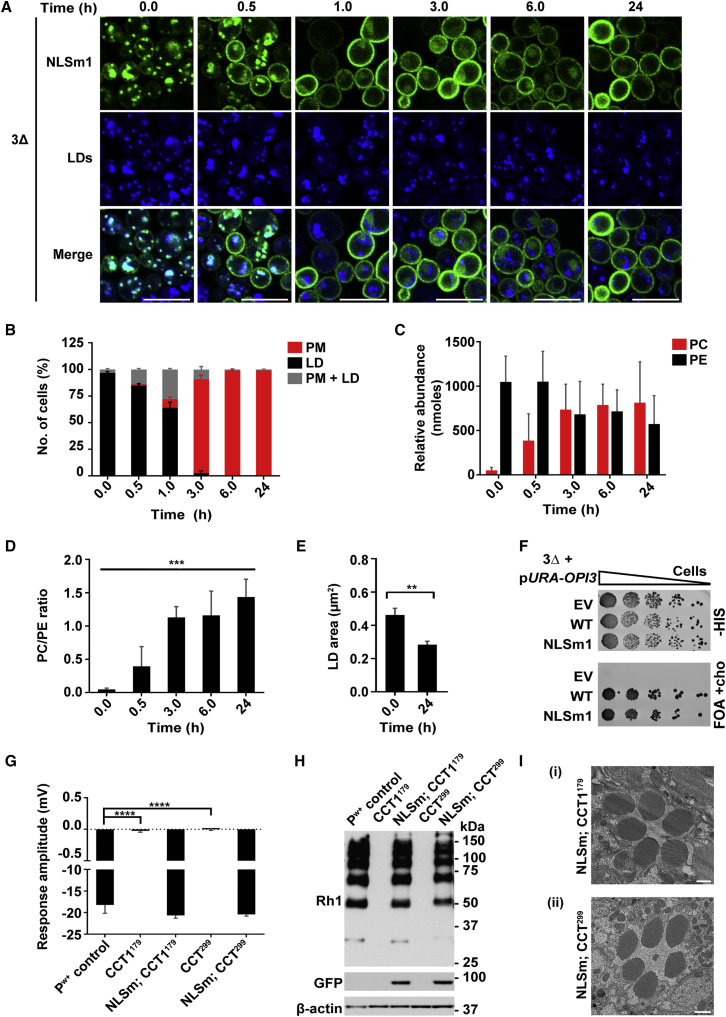
CCT NLS Mutants Can Compensate for the Loss of WT CCT in Yeast and in Drosophila PRs(A–F) 3Δ yeast cells expressing Pct1-NLSm1-GFP were grown for 24 hr followed by addition of 1 mM choline. Cells were collected before (0.0 hr) and after choline supplementation at the indicated time points for imaging or lipidomics analysis.(A) Representative confocal microscopy images of Pct1-NLSm1 localization. LDs were stained as described in the STAR Methods. Merged (Merge) fluorescent channels show co-localization. Scale bars, 10 μm.(B) Quantification of the Pct1-NLSm1-GFP localization shown in (A); PM, plasma membrane; LD, Lipid droplet. Data are means ± SD based on random fields from three independent experiments; ∼300 cells were counted at each time point per experiment.(C) PC and PE levels at the indicated time points shown in nmol (per 50 mg yeast) are relative to internal standards. Data represent the means ± SD based on measurement from three independent experiments.(D) PC/PE ratio at the indicated time points from data in (C). Data are means ± SD. One-way ANOVA, ∗∗∗p < 0.001.(E) Measurement of LD area from cells imaged in (A) as described in the STAR Methods. Data are means ± SD from three independent experiments; ∼600 LDs were counted per condition. Two-tailed Student's t test, ∗∗p < 0.01.(F) 3Δ cells carrying Ycplac33-URA3-OPI3 were transformed with CEN/HIS3 plasmids expressing either WT Pct1, NLSm1, or the corresponding empty plasmid (EV). Cells were grown to exponential phase and serial dilution of liquid cultures were spotted onto plates lacking histidine (-HIS) or plates supplemented with 5-FOA.(G–I) The “blind” phenotype of the CCT1179 and CCT299 homozygous eyes was rescued by transgenic retinal expression of a CCT1-NLSm-GFP mutant, CCT1-NLSm; CCT1179 and CCT1-NLSm; CCT299.(G) Response to light activation was assessed by ERG scans and the mean response generated at the maximal intensity was plotted for four to six flies of each genotype. Flies with CCT1 null eyes are completely blind even at the maximum intensity, while the CCT1-NLSm-GFP expression restores the response to WT levels. Data are reported as means ± SD. One-way ANOVA with Bonferroni multiple comparison, ∗∗∗∗p < 0.0001. (H) The CCT1-NLSm-GFP mutant restores the rhodopsin level in flies with CCT1 null eyes (CCT1179 or CCT299) back to the control levels. (I) Transmission electron micrographs of retinal tissue sections from flies with CCT1 null eyes rescued by transgenic expression of CCT1-NLSm-GFP mutant, CCT1-NLSm; CCT1179 (i) and CCT1-NLSm; CCT299 (ii). Rhodopsin (Rh1) promoter-driven expression of CCT1-NLSm allows normal development of rhabdomere stacks in the PRs 1–6. Scale bars, 500 nm.See Figure S7.